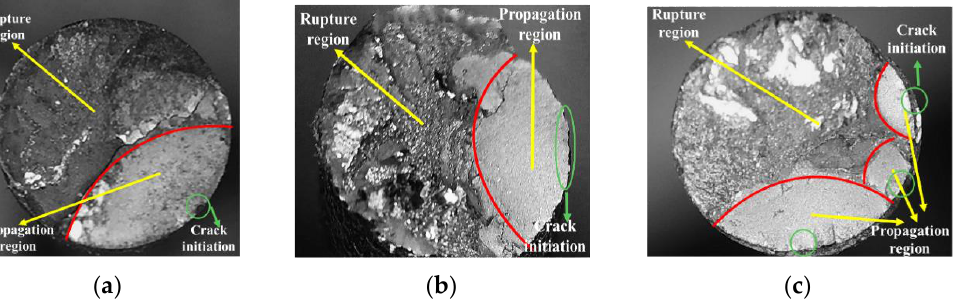
Figure 14. Scanning electron morphology of whole fatigue fracture of corroded wire. ( a ) Type Ⅰ , ( b ) Type Ⅱ and ( c ) Type